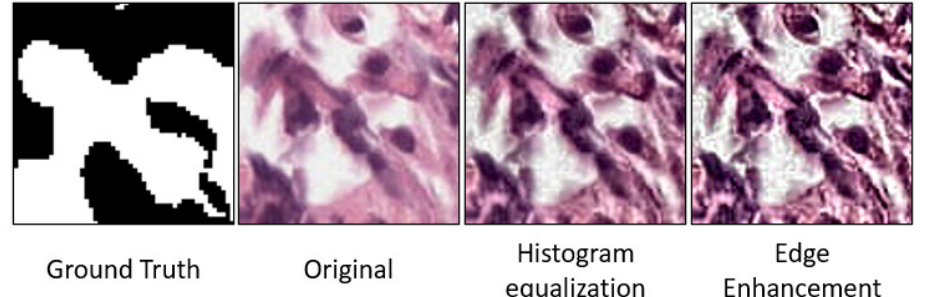
Figure 4. Example for applying prepossessing step on original patch: histogram equalization and edge enhancement.